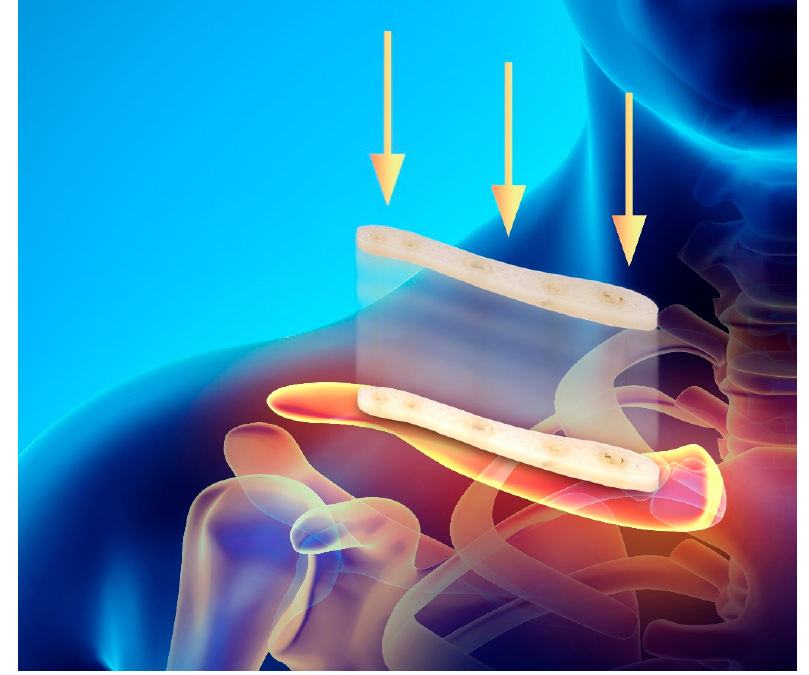
Figure 12. Graphical representation of a PHBH clavicle plate 3D printed by FDM and its final surgical application for bone regeneration (adapted from istock.com/yodiyim, accessed on 21 September 2020).